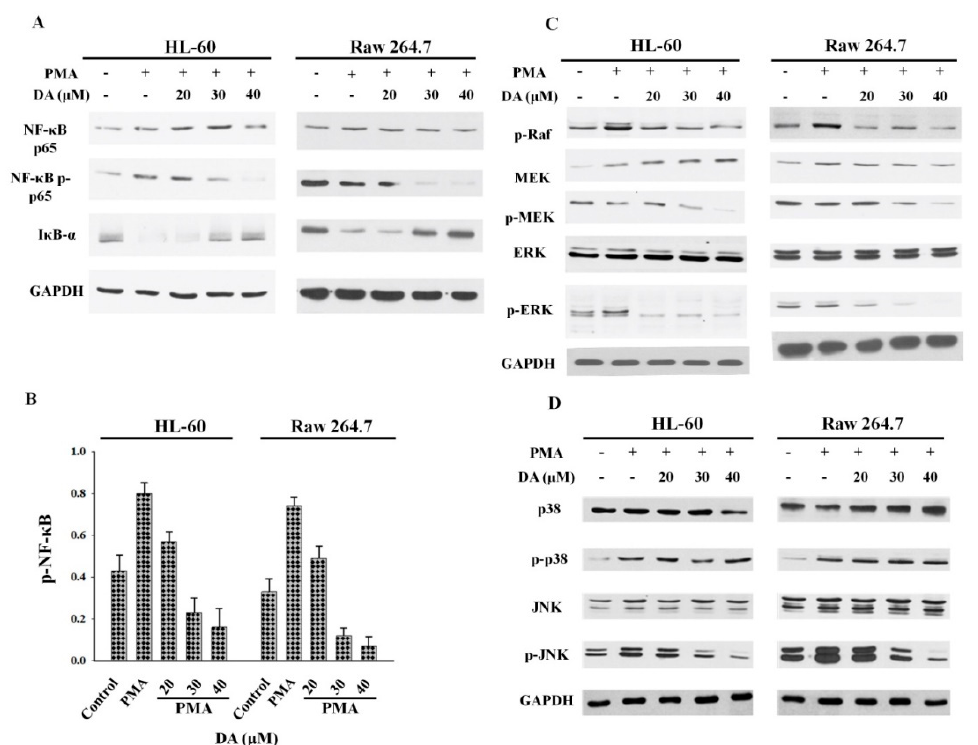
Figure 2. DA inhibits the NF κ B and MAPK signaling pathways in PMA-induced macrophages. ( A ) treatment with DA abolished the activation of the NF κ B pathway in PMA-induced macrophages. Cells were treated with PMA for 12 h in the dark and then incubated with different concentrations of DA (0, 20, 30, 40 μ M) for the indicated amounts of time. Cell lysates were separated through 10% SDS-PAGE, and proteins were detected using an ECL Western blotting detection reagent. GAPDH was used as internal control; ( B ) NF κ B phosphorylation was quantified using the software Image J. The results from three independent experiments are presented in a bar chart; ( C ) DA inhibits the activation of the ERK and JNK pathways. Cells were incubated with PMA or DA for the specified amounts of time, and the levels of total and phosphorylated proteins involved in the MAPK pathway were analyzed through Western blot. GAPDH was used as internal control; ( D ) cells were incubated with either PMA or DA for specified interval of time and MAPK pathway total and/or phosphorylated proteins were analyzed by Western blot.